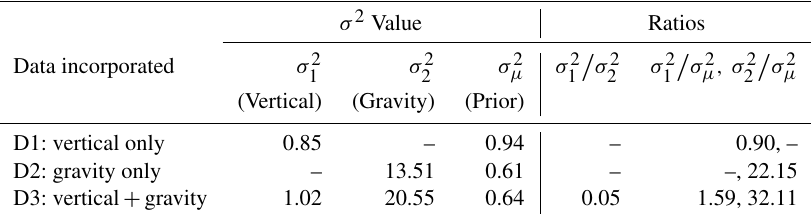
Figure 6. Prediction of present-day vertical land motion (a) and uncertainties (b) due to long-term GIA for the D1–D3 scenarios. Table 2. Results of the variance component analysis. σ 2 and σ 2 are the variance factors applied to the vertical motion data (dataset 1) and 1 2 gravity change data (dataset 2), respectively, and σ 2 µ is the variance factor applied to the prior information. The ratios describe how each input covariance matrix is weighted relative to the